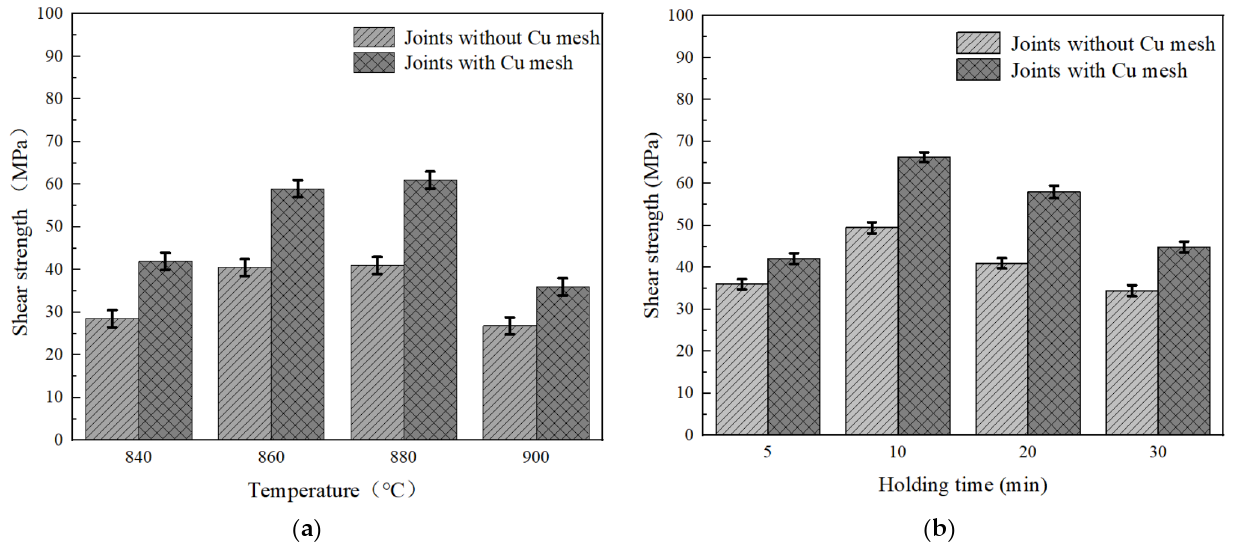
Figure 9. The compassion of mechanical property between the brazed joints with and without copper mesh under different brazing parameters: ( a ) the condition with the same holding time and different brazing temperature and ( b ) the condition with the same temperature and different holding time.